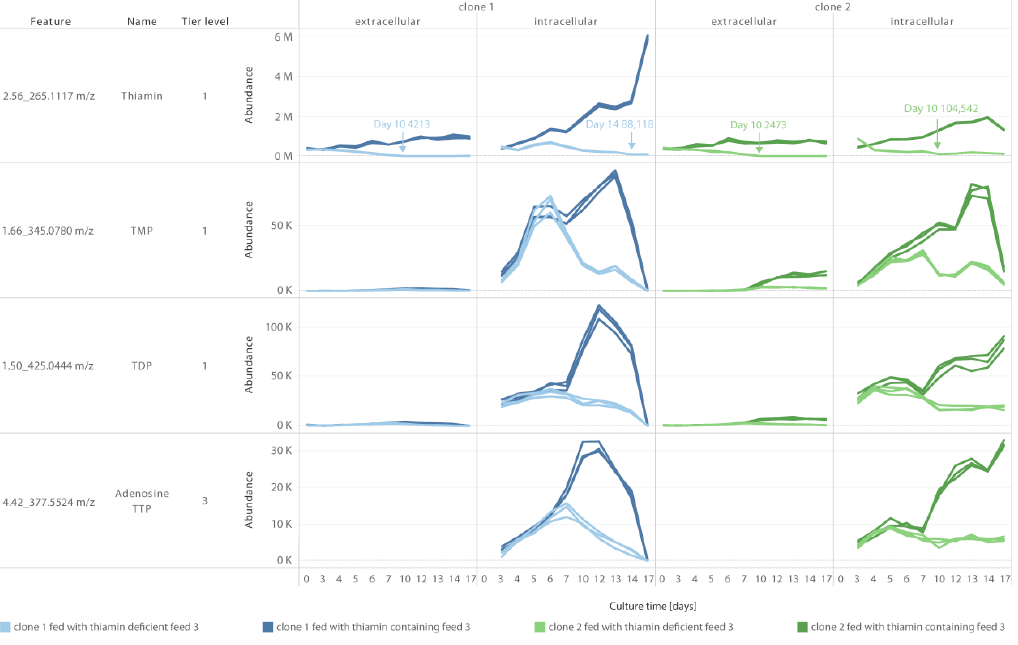
Figure 5. Thiamin species detected extra- and intracellularly during the FB. Lighter color indicates the conditions without thiamin in feed 3. Darker color indicates the conditions containing thiamin in feed 3. N = 3. Timepoint and lowest thiamin abundance highlighted for conditions fed with a thiamin-deficient feed.